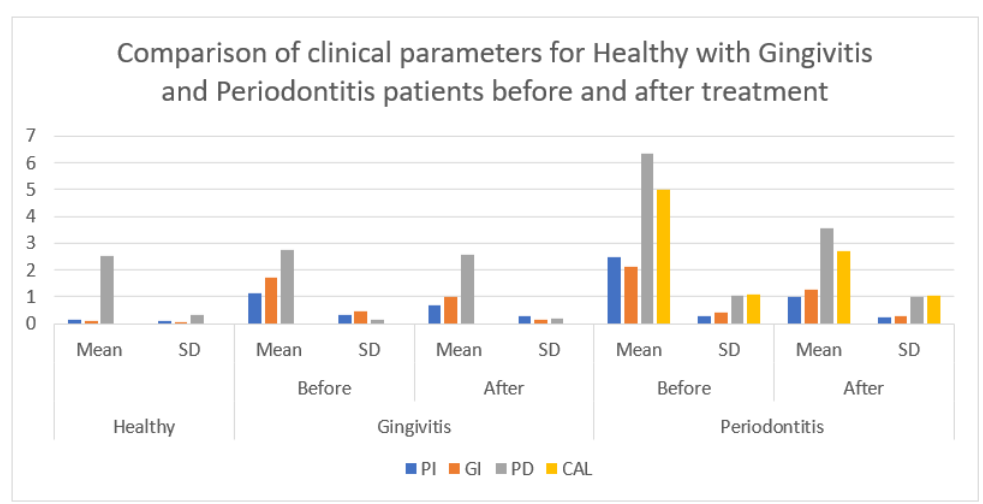
Figure 2. Comparison of parameters for Healthy with Gingivitis and Periodontitis patients before and after